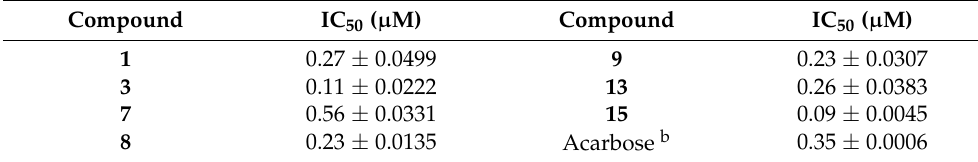
Table 3. α -glucosidase inhibitory activity of compounds 1, 3, 7, 8, 9, 13 and 15 . ( n = 3) a